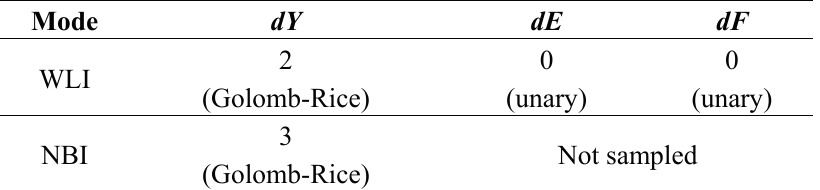
Table 3. K parameter for encoding component